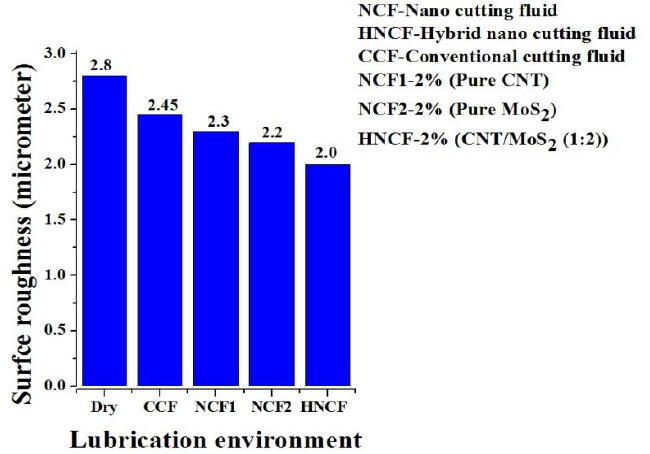
Figure 5. Variation of surface roughness (R a ) with different lubrication environment (CS=80 m/min, FR=